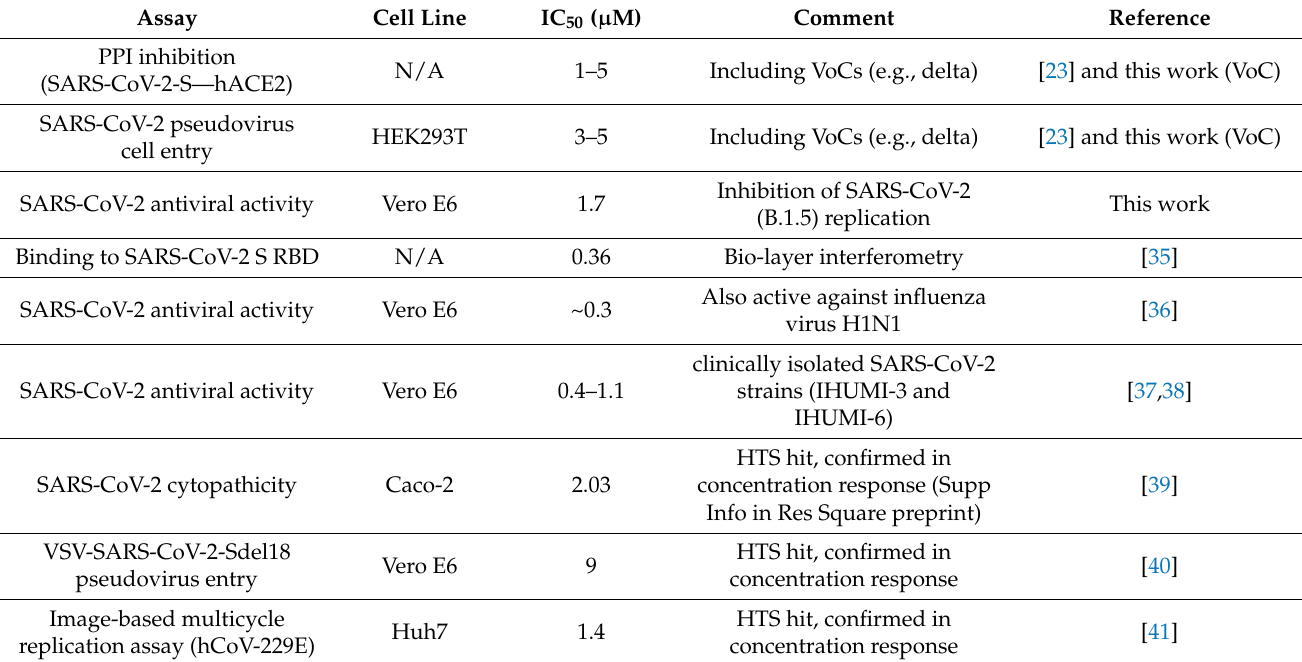
Table 1. Summary of published peer-reviewed studies showing anti-SARS-CoV-2 activity for